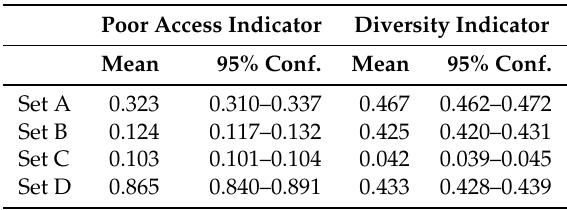
Table 5. State variables’ mean convergence values and 95% confidence intervals across 50 runs for each set of exploratory simulations. Set A represents the baseline, Set B represents high income inequality, Set C represents low density, and Set D represents dispersed amenities and wide relocation radii.